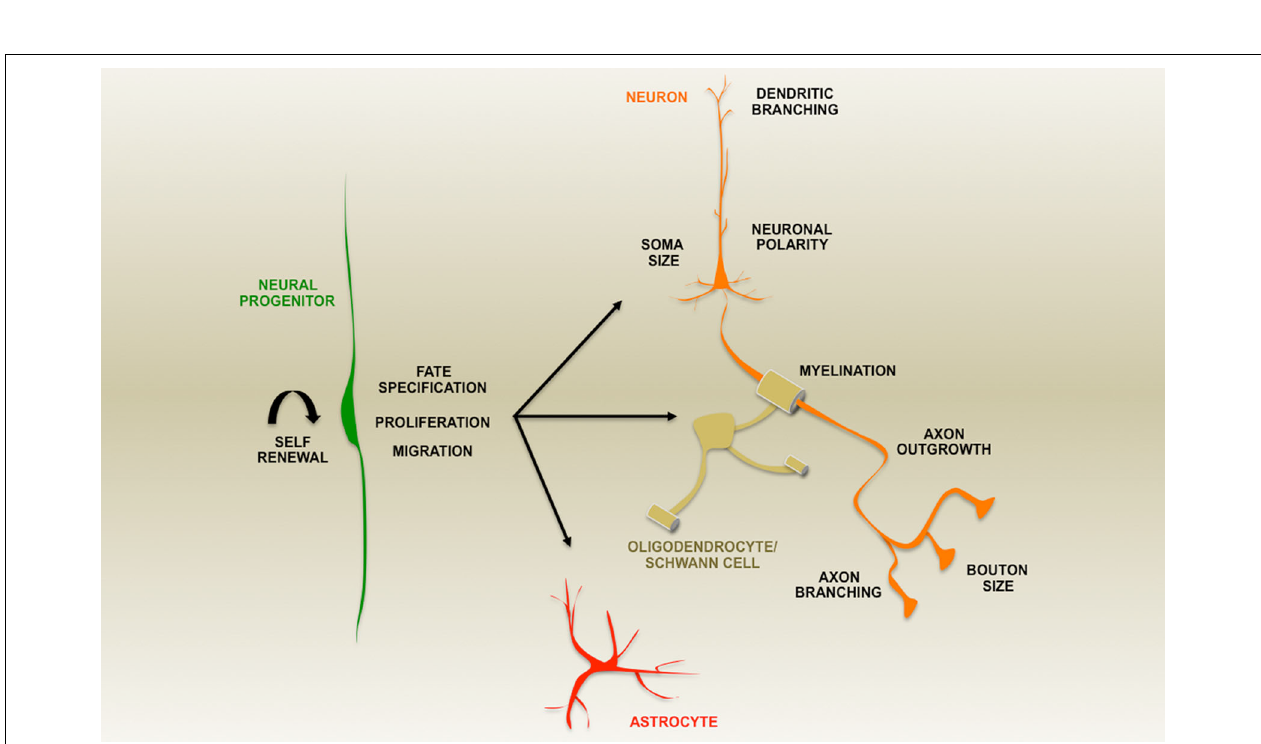
FIGURE 2 | A summary of aspects of nervous system development altered by loss of PTEN expression during development or in post-natal ablation studies as indicated by the text.